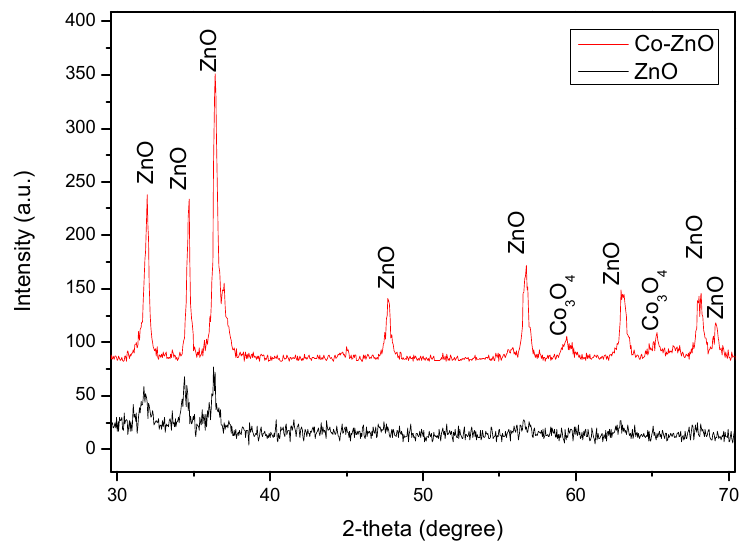
Figure 2. XRD patterns of pristine ZnO and Co-doped ZnO NPs.